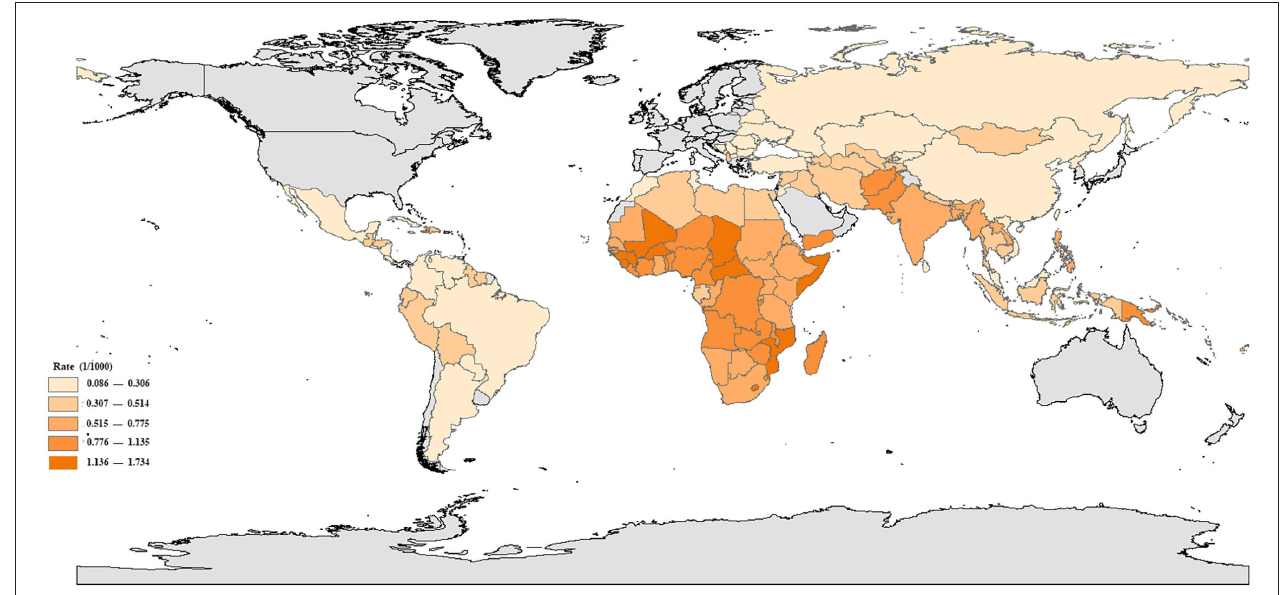
FIGURE 1 | Mortality rates in children aged 5–14 years in 137 low- and middle-income countries, in 2019.